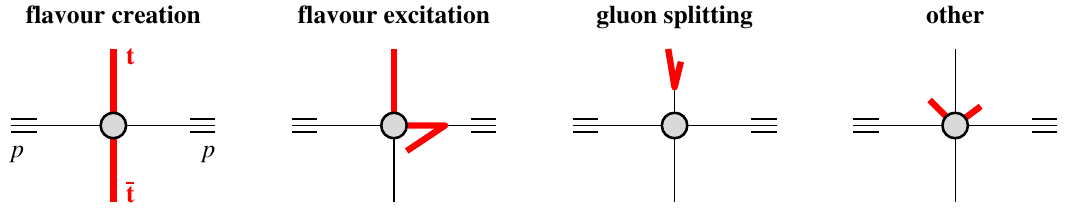
Figure 1 . Illustration of classes of event topology for top production. Thick red lines represent top (anti-)quarks, while thin black lines represent light partons (quarks or gluons). Protons are depicted as entering from the left and right-hand